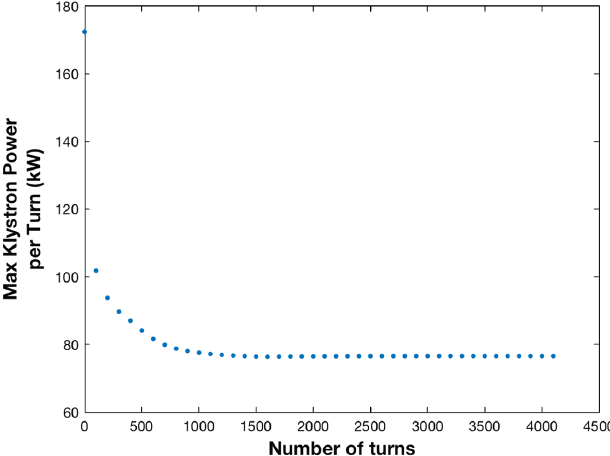
FIG. 7. Peak power reduction as the algorithm optimizes the phase